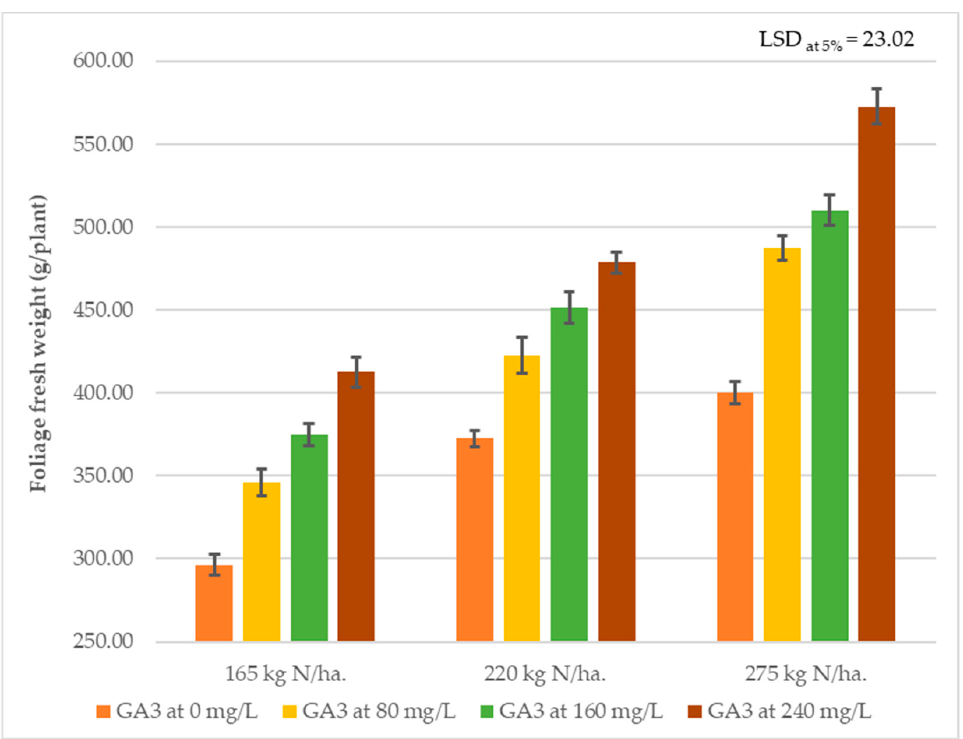
Figure 6. Foliage fresh weight (g/plant) as affected by the interaction between nitrogen fertilizer levels and GA 3 spraying concentrations in the second season (2015/2016).